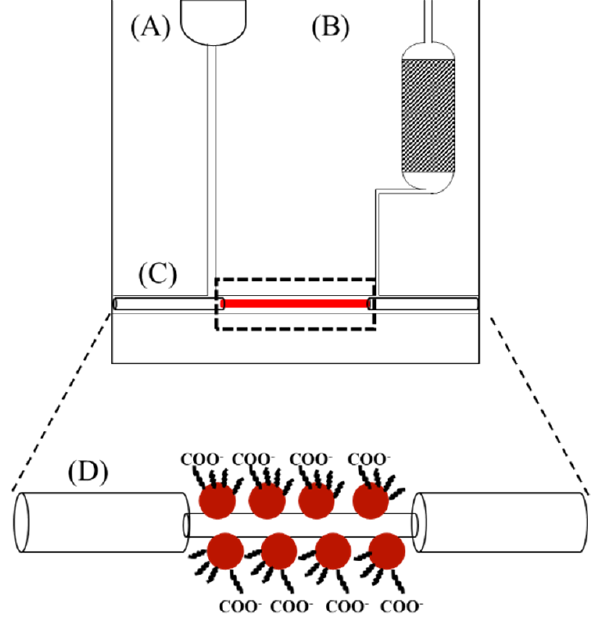
Figure 3. A schematic of the microfluidic sensor chip (NanoAu-MM): ( A ) Fluid injection section; ( B ) fluid storage section, where the porous material is located in the shaded area; ( C ) detection section; and ( D ) exploded view of the sensor fiber in the detection section ( C ).